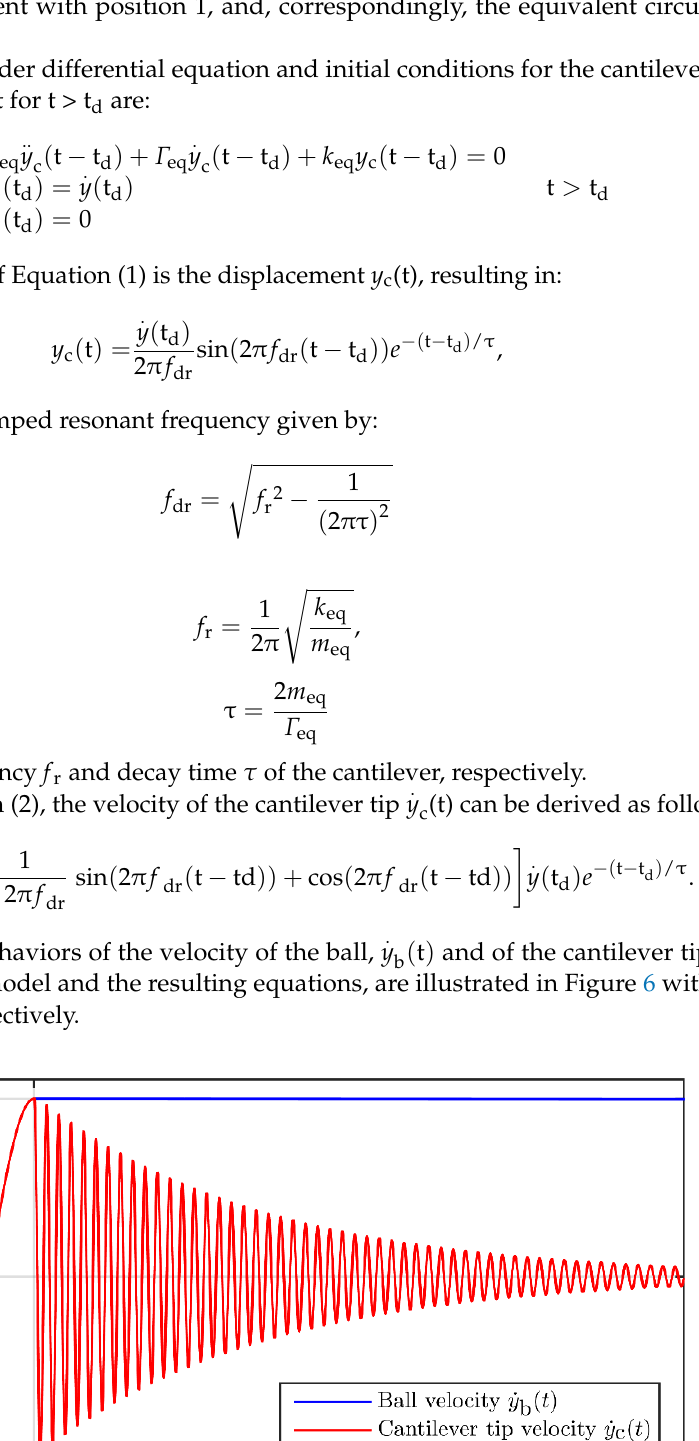
Figure 6. Typical behaviors of the velocity of the ball, y (cid:4662) (t) (red curve), caused by an impact.